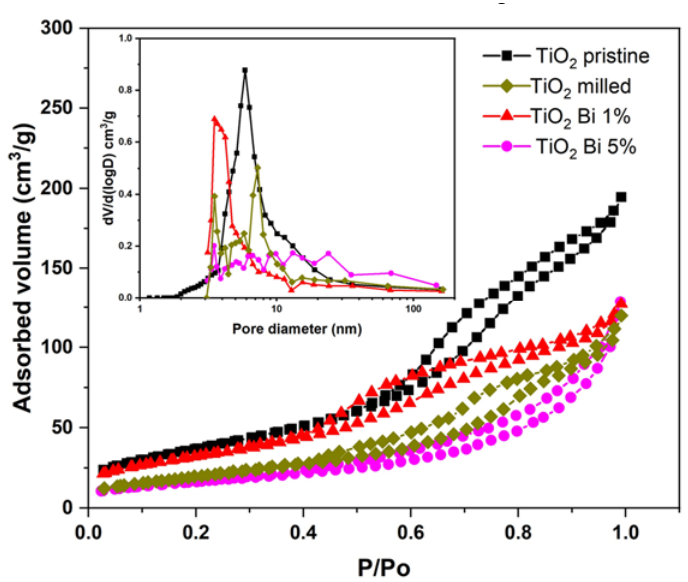
Figure 5. N 2 adsorption–desorption isotherms and pore diameter distribution of the pristine TiO 2 , milled TiO 2 , TiO 2 Bi 1%, and TiO 2 Bi 5% samples. Table 1. Specific surface area (S BET ), mean pore diameter (D p ) and mean pore volume (V p ) of the samples pristine TiO 2 , milled TiO 2 , TiO 2 Bi 1%, and TiO 2 Bi